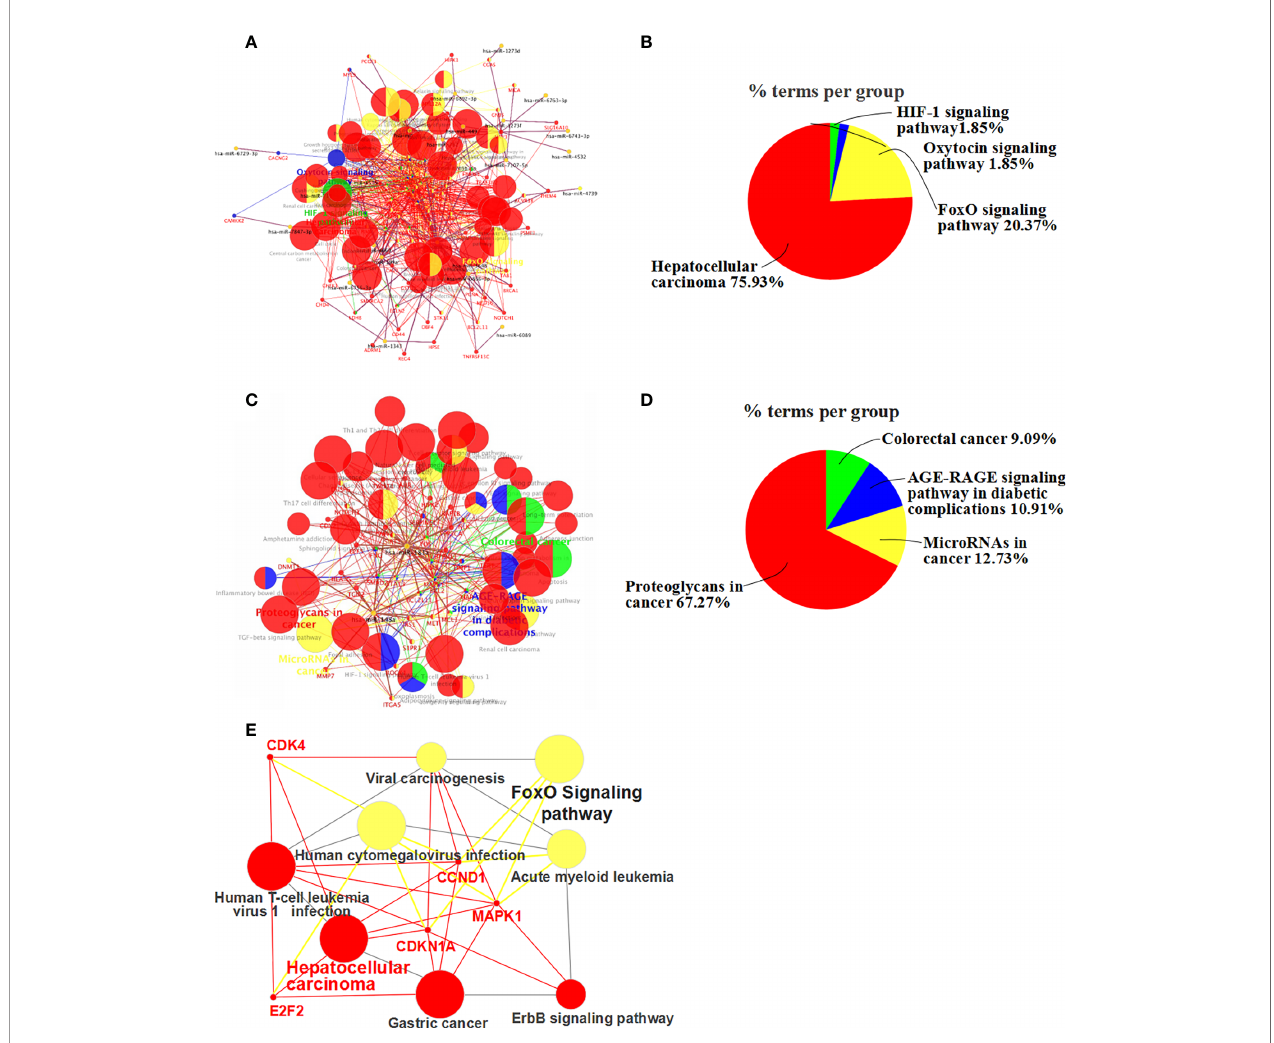
FIGURE 5 | KEGG pathway enrichment analysis of differentially expressed miRNA-related target genes. (A) Up-regulated miRNA and associated target gene signaling pathways (up-regulated miRNAs-pathway-genes) in apigenin-treated Huh7 cells. (B) The percentage of the up-regulated miRNA-related signaling pathways. (C) Down-regulated miRNA and target gene signaling pathways in apigenin-treated Huh7 cells (down-regulated miRNAs-pathway-genes). (D) The percentage of the down-regulated miRNA-related signaling pathways. (E) Up-regulated miRNA-FoxO signaling pathways-genes in apigenin-treated Huh7